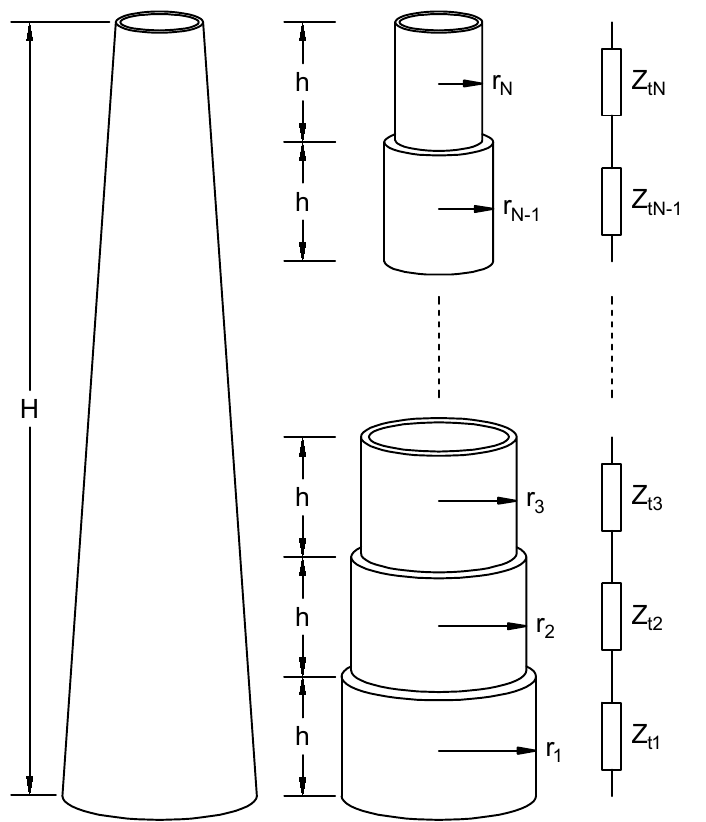
Figure 2. Schematic representation of the multi-story WT tower